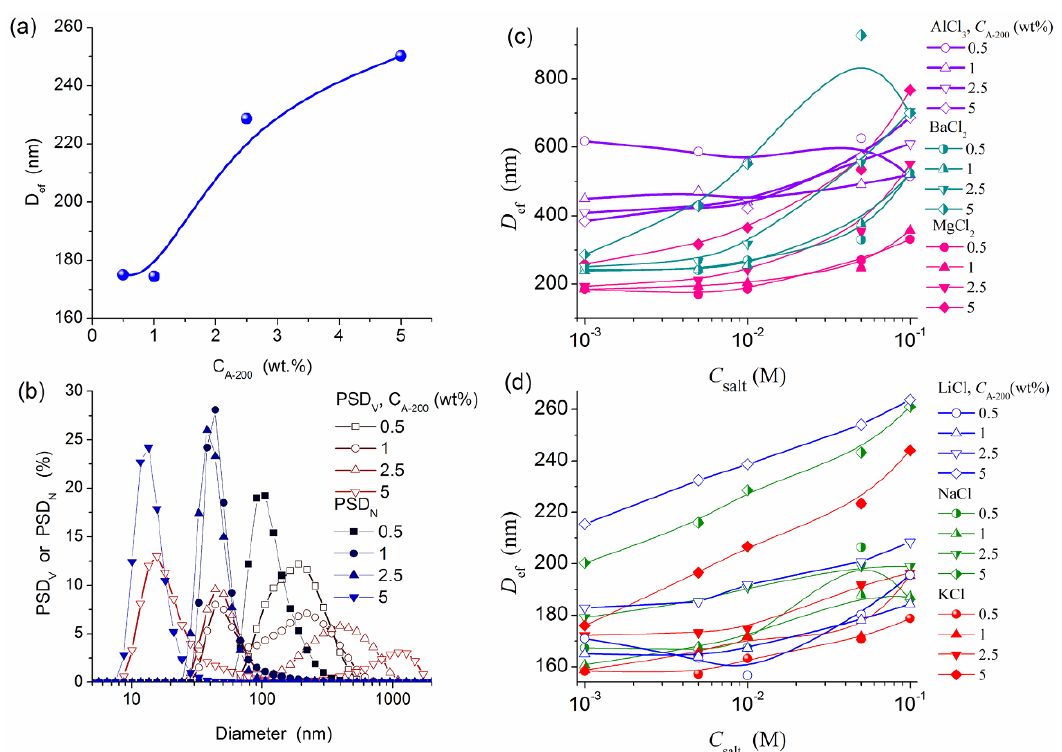
Figure 1. Effective diameter of particles (determined from the light scattering intensity) as a function of (a) silica content without addition of any electrolyte; (c, d) the salt content (0.001-0.1 M) for (c) AlCl (0.5-5 wt.%) in the aqueous suspensions; and (b) PSD with respect of the particle volume (PSD suspension of A-200 without